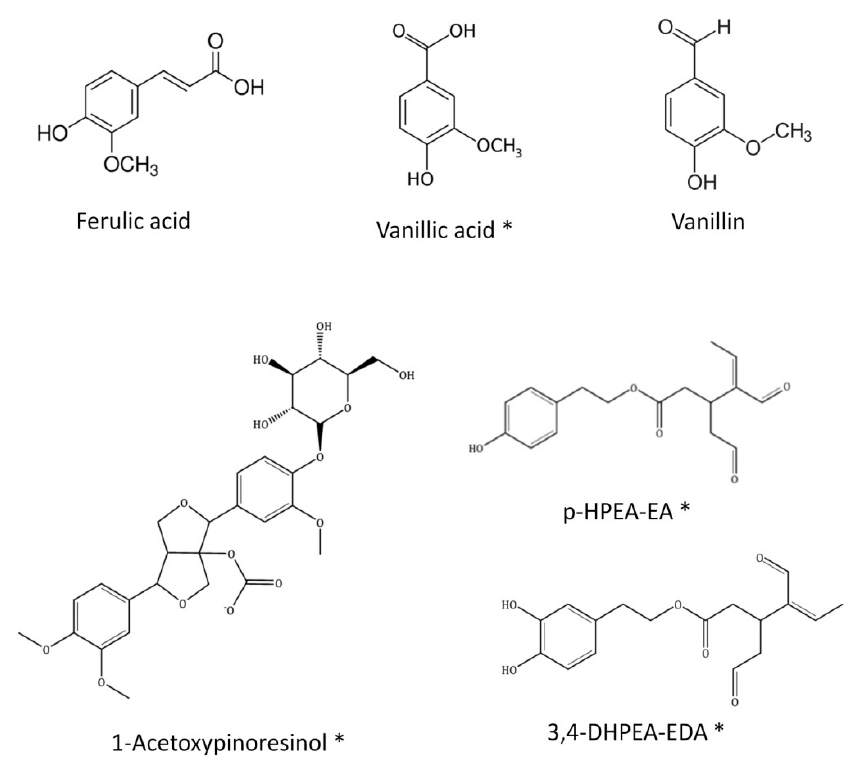
Figure 3. Chemical structure of the compounds identified in SEEP previously found in olive oils. (*) Compounds indentified for the first time in a propolis sample.